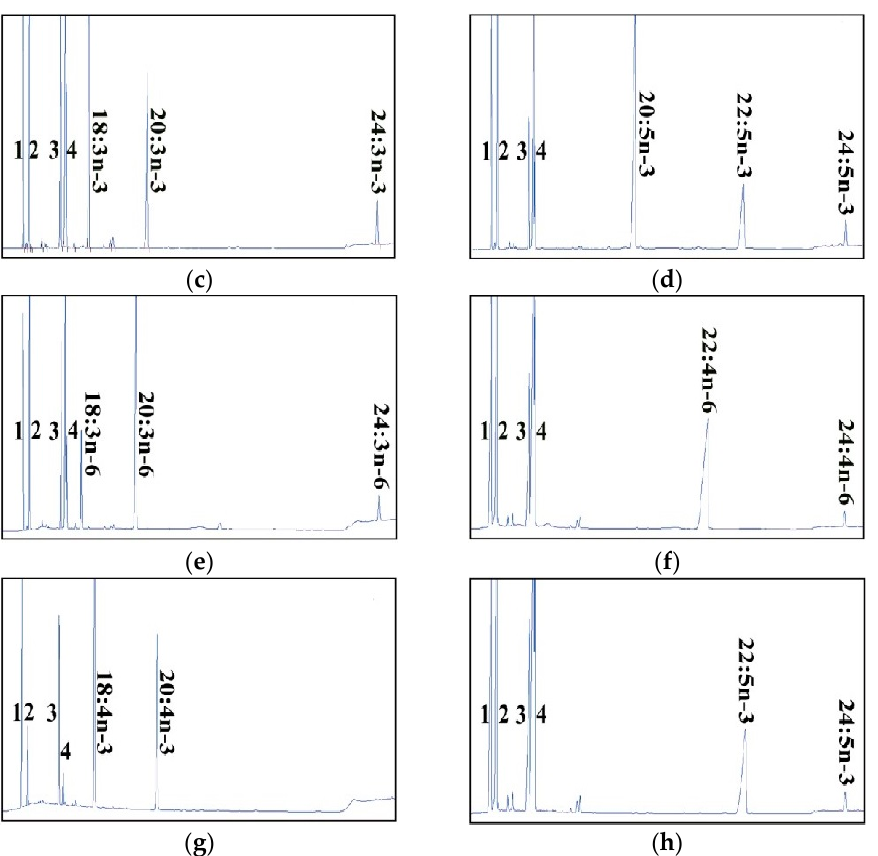
Figure 1. The elongase activities of common carp Elovl5a towards different substrates in the trans- genic yeast grown with ( a ) C18:2n-6, ( b ) C20:4n-6, ( c ) C18:3n-3, ( d ) C20:5n-3, ( e ) C18:3n-6, ( f ) C22:4n-6, ( g ) C18:4n-3 and ( h ) C22:5n-3. The peaks from 1 to 4 represent C16:0 (1), C16:1n-7 (2), C18:0 (3) and C18:1n-9 (4), respectively, which are the four main endogenous FAs of yeasts. The substrates and their corresponding products were indicated. The vertical axis displayed the flame-ionization detector response peak. The horizontal axis showed the peak retention time (min). Table 1. Functional characterization of Elovl5a and Elovl5b.